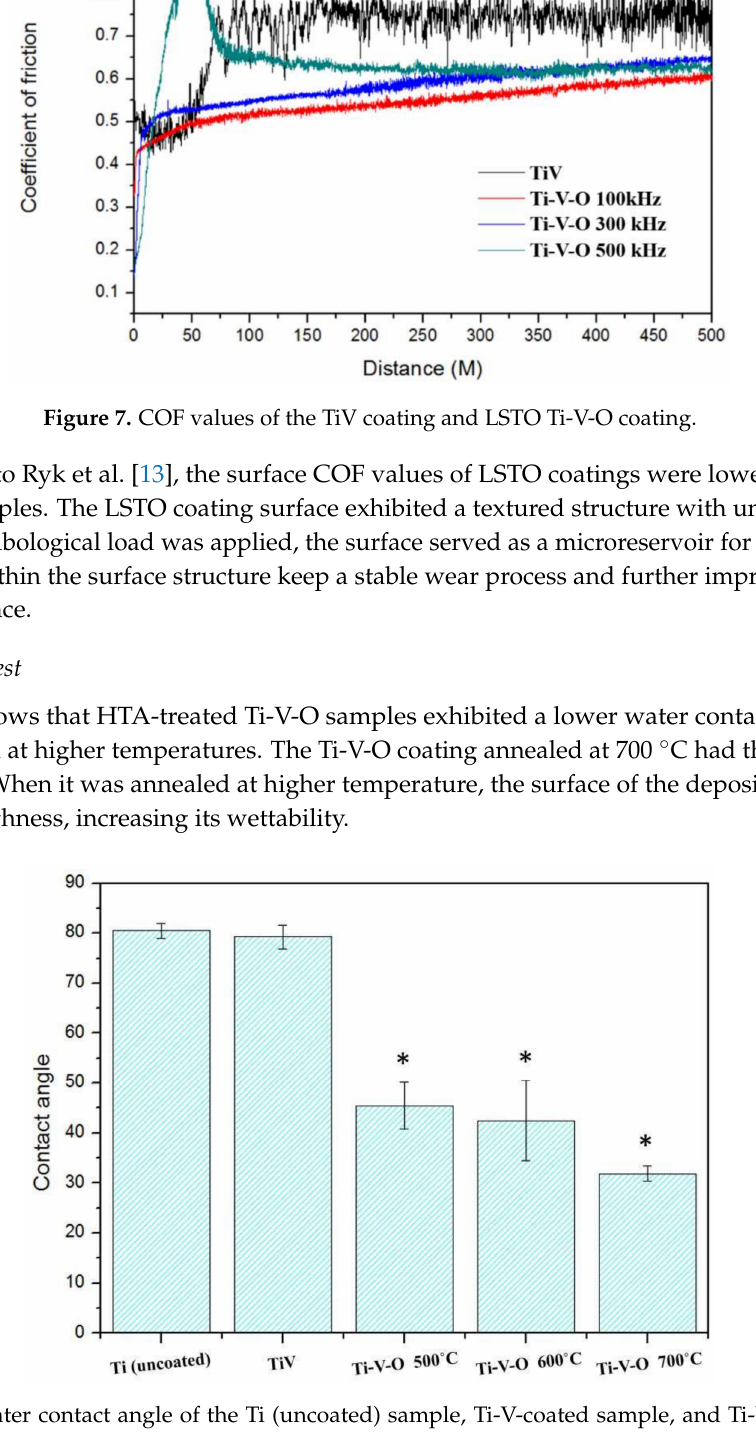
Figure 8. Water contact angle of the Ti (uncoated) sample, Ti-V-coated sample, and Ti-V-O-coated sample subject to HTA. * Significantly different from the control group—uncoated Ti plate ( p <